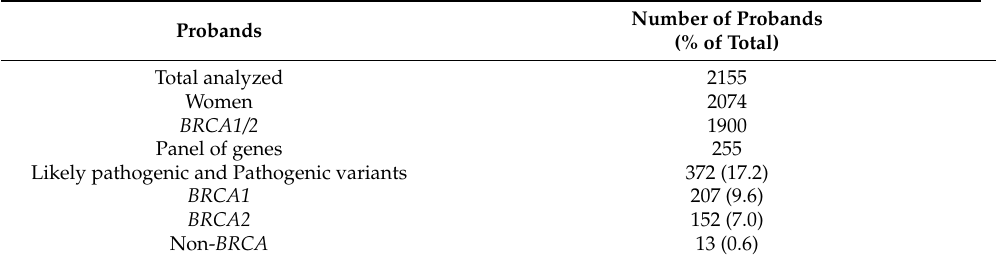
Table 1. Probands analyzed for BRCA1/2 genes and the panel of